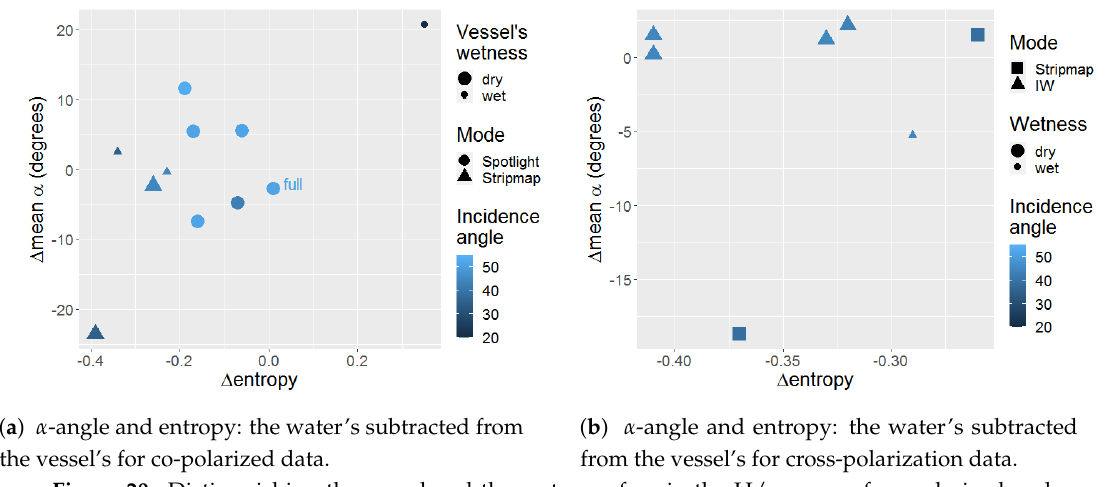
( a ) α -angle and entropy: the water’s subtracted from the vessel’s for co-polarized data. Figure 20. Distinguishing the vessel and the water surface in the H/ α -space of co-polarized and cross-polarization